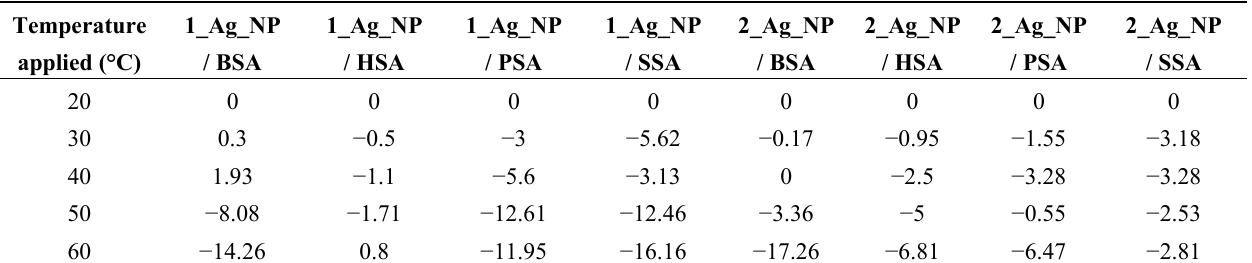
Table 4. Percentage changes of the maximum absorption of calixarenes-capped silver nanoparticles against Serum Albumin a as function of temperature, after 5 min.